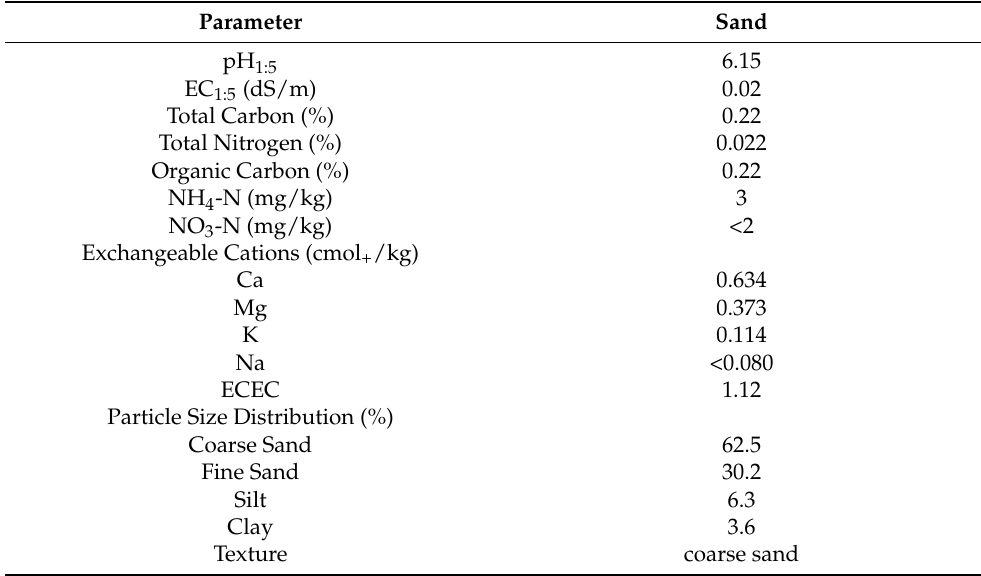
Table 1. Selected properties of the sand. EC = electrical conductivity, ECEC = effective cation exchange